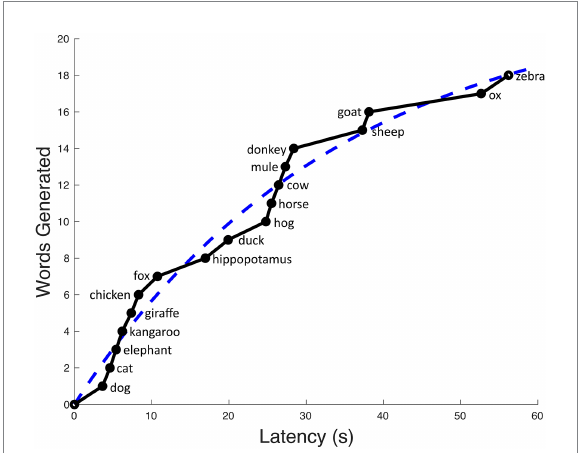
FIGURE 2 The black, jagged curve depicts the number of animal words actually generated over time. To this curve, we fit an exponential curve (blue dashes). The chains of animals linked based on positive slope difference are: [dog, cat, elephant, kangaroo, and chicken], [fox], [hippopotamus], [duck], [hog, horse, cow,